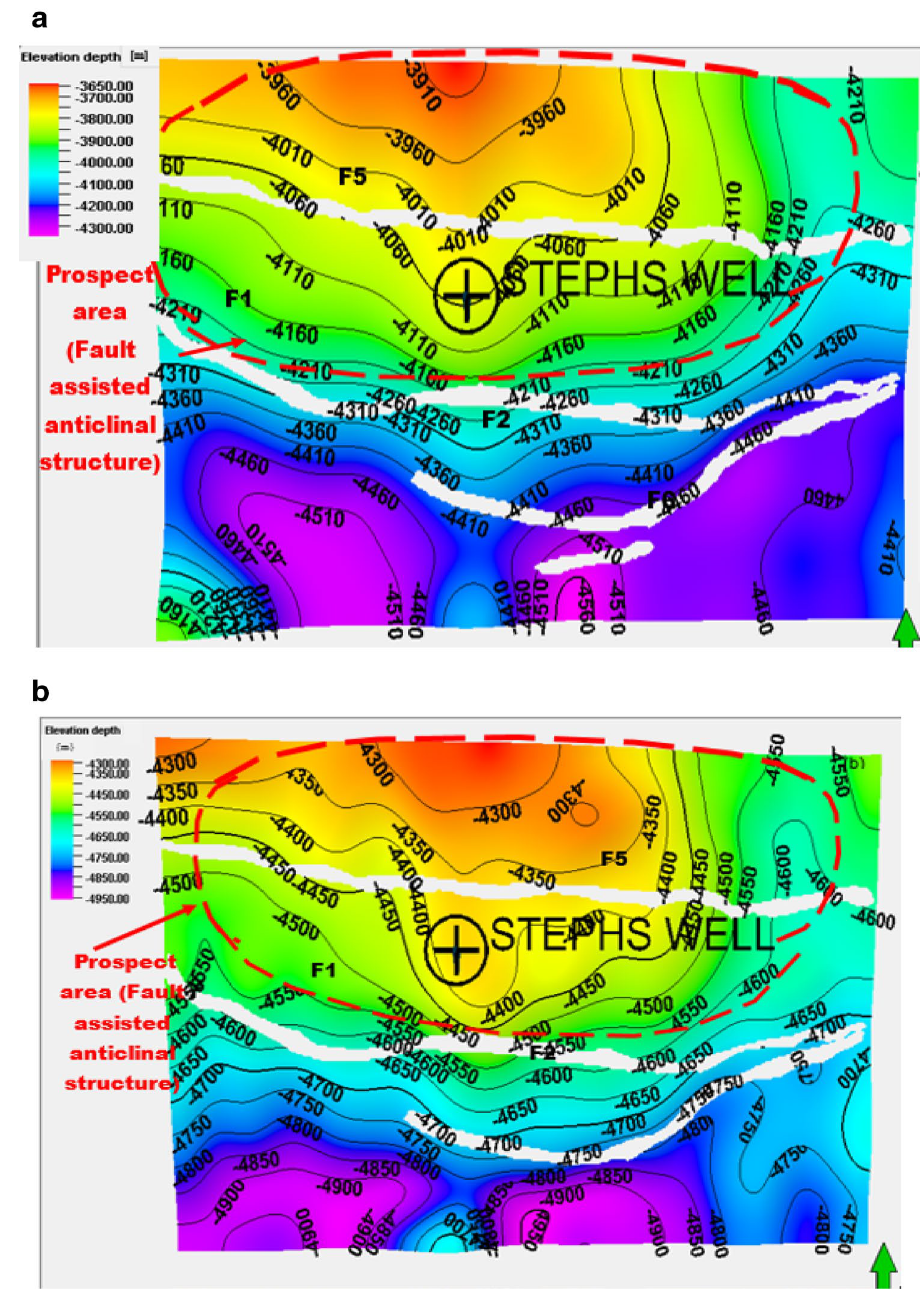
Fig. 9 a Depth structure map of horizon B. b Depth structure map of horizon